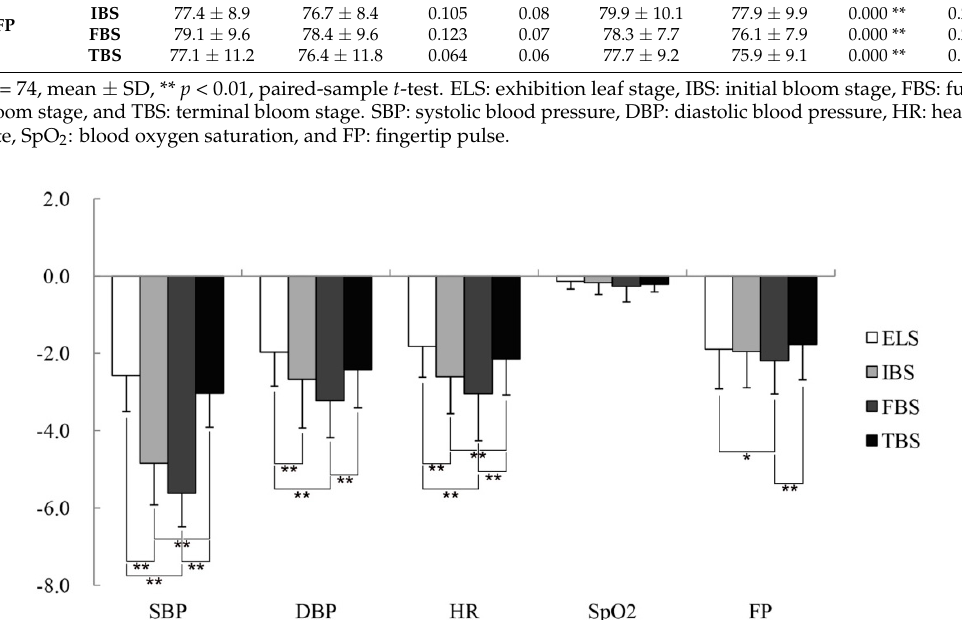
Figure 5. Comparison of physiological index changes among the experimental groups. ELS: exhibition leaf stage, IBS: initial bloom stage, FBS: full bloom stage, and TBS: terminal bloom stage. SBP: systolic blood pressure, DBP: diastolic blood pressure, HR: heart rate, SpO 2 : blood oxygen saturation, and FP: fingertip pulse. N = 74, mean ± SD. * p < 0.05, ** p < 0.01, one-way ANOVA.